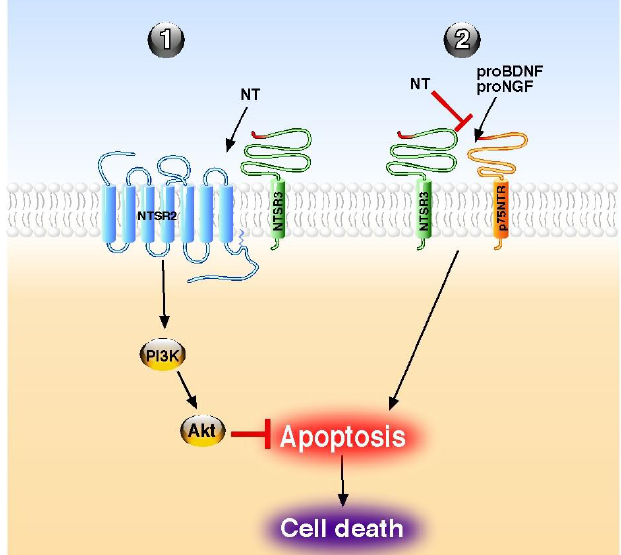
Figure 1. Molecular mechanisms of NT on apoptosis regulation. NT acts directly through its receptors to block the apoptosis ( 1 ) or indirectly by competition to reverse